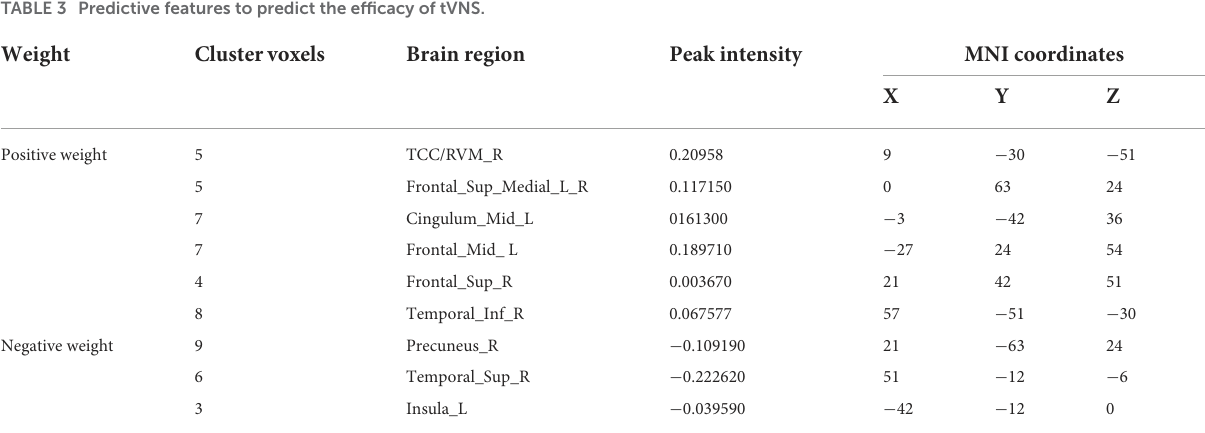
TABLE 3 Predictive features to predict the efficacy of